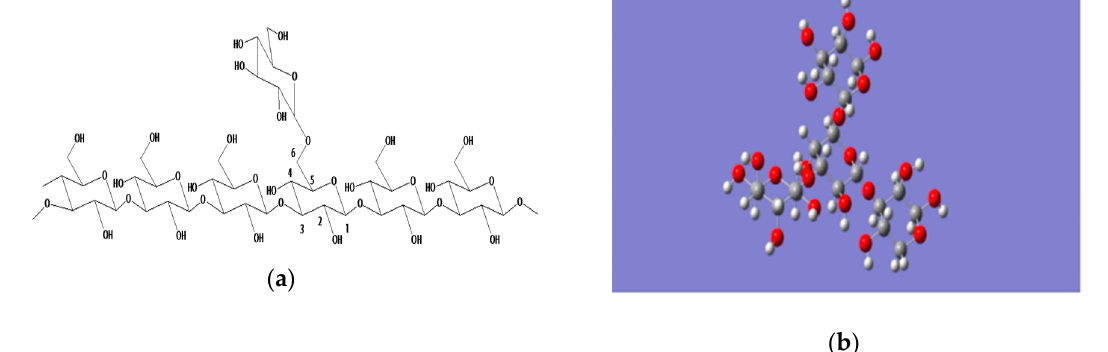
Figure 2. The structure of yeast β -glucan ( a ) One-dimensional structures of yeast β -glucan; ( b ) Three-dimensional structure of yeast β -glucan.